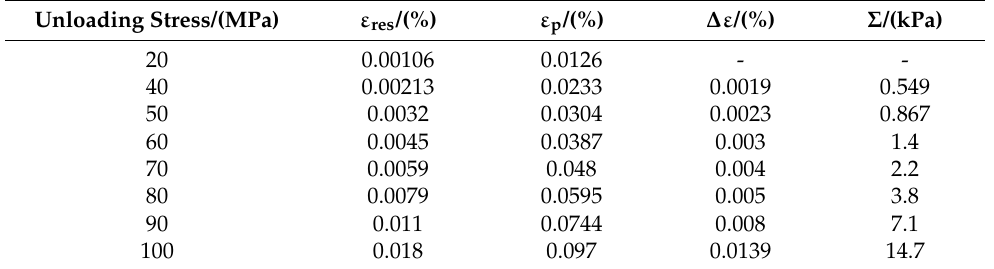
Table 4. Cyclic loading/unloading damage parameters of Type 2 3D needle-punched C/SiC